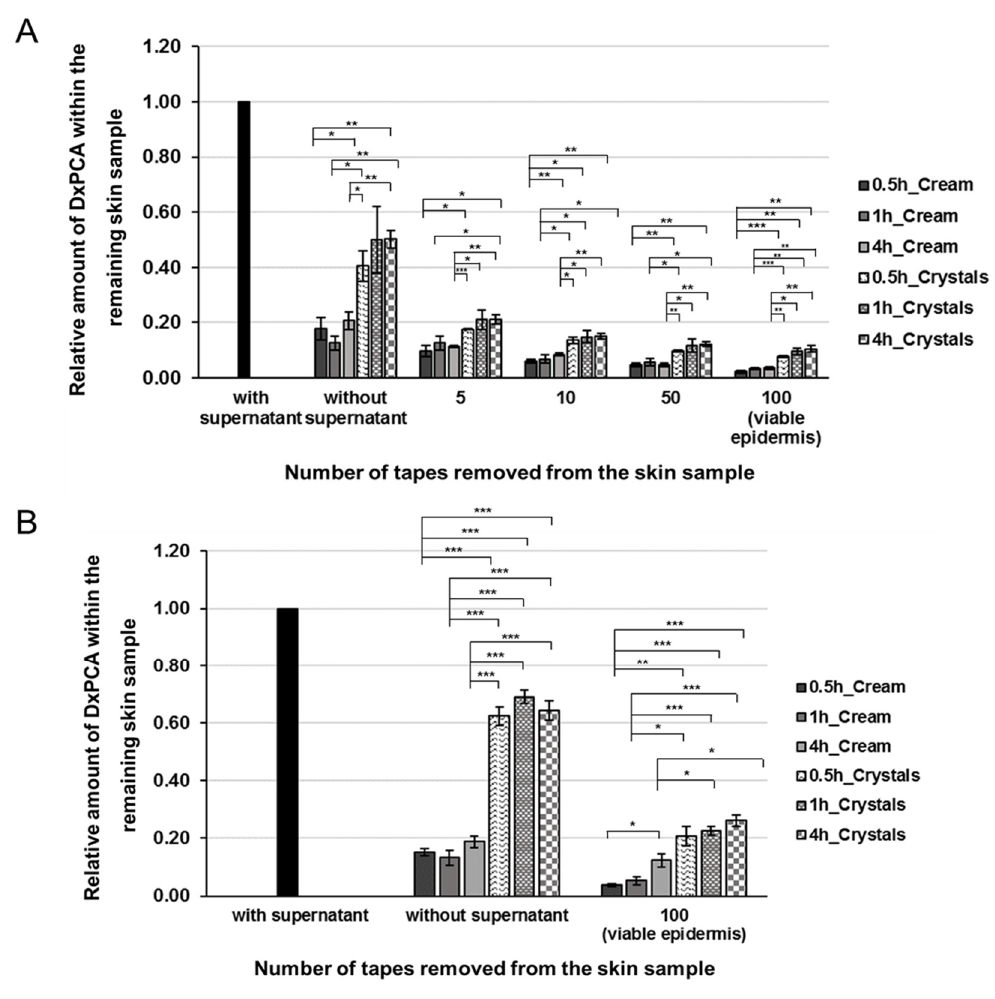
Figure 3. Distribution profile of DxPCA in the remaining intact ( A ) and barrier-disrupted ( B ) skin samples after the topical application of a base cream (monochrome, 1mM), a nanocrystal suspension (pattern design, 1mM), and various incubation times (0.5, 1 and 4h). To analyze the distribution of DxPCA in intact skin different amounts of the stratum corneum (SC) were removed by tape stripping and the remaining skin samples were analyzed. To analyze the amount of DxPCA within the viable epidermis of barrier-disrupted skin, an additional 50 tapes were removed after the respective incubation time; for the intact skin, 100 tapes were removed; Mean ± SEM, * p ≤ 0.05, ** p ≤ 0.01, *** p ≤ 0.001.